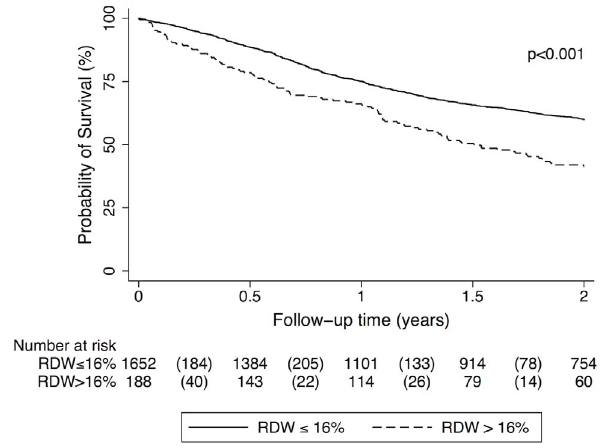
Figure 3. Kaplan-Meier estimates for cumulative survival probability of cancer patients (total study cohort) with red blood cell distribution width (RDW) . 16% and below ( # 16%), respectively. Survival rates were significantly lower in patients with high RDW in comparison to those with a non-elevated RDW (p , 0.001). Numbers in parentheses indicate numbers of deaths in the respective group and time period.